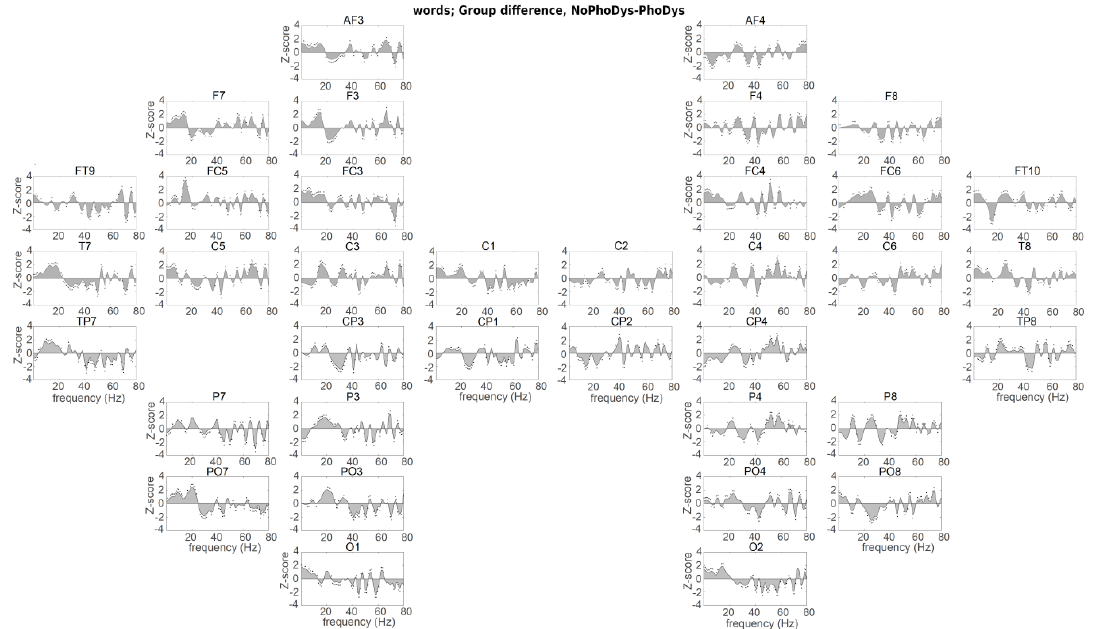
Figure 3. Hemispheric presentation of group difference between controls and PhoDys for the word listening condition. Same format as Figure 2.